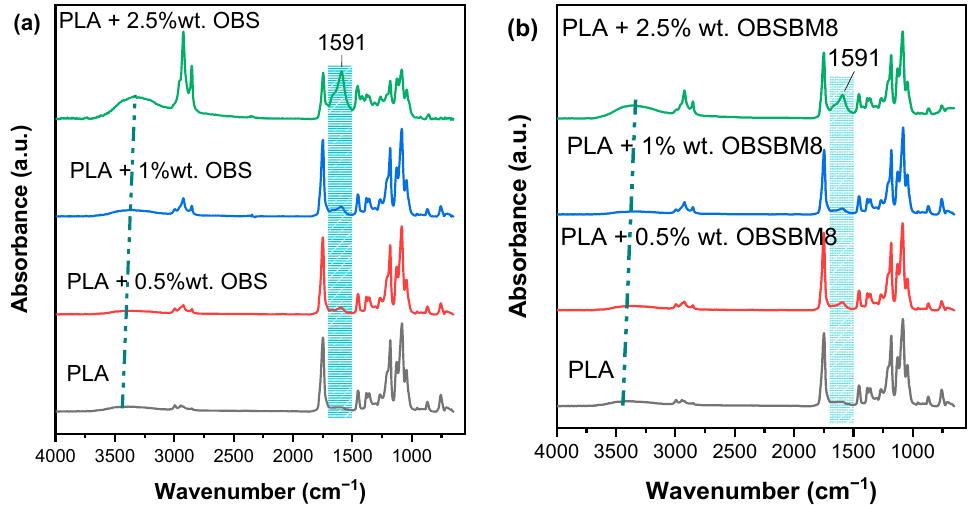
Figure 5. FTIR spectra of ( a ) PLA/OBS and ( b ) PLA/OBSBM8 composites.